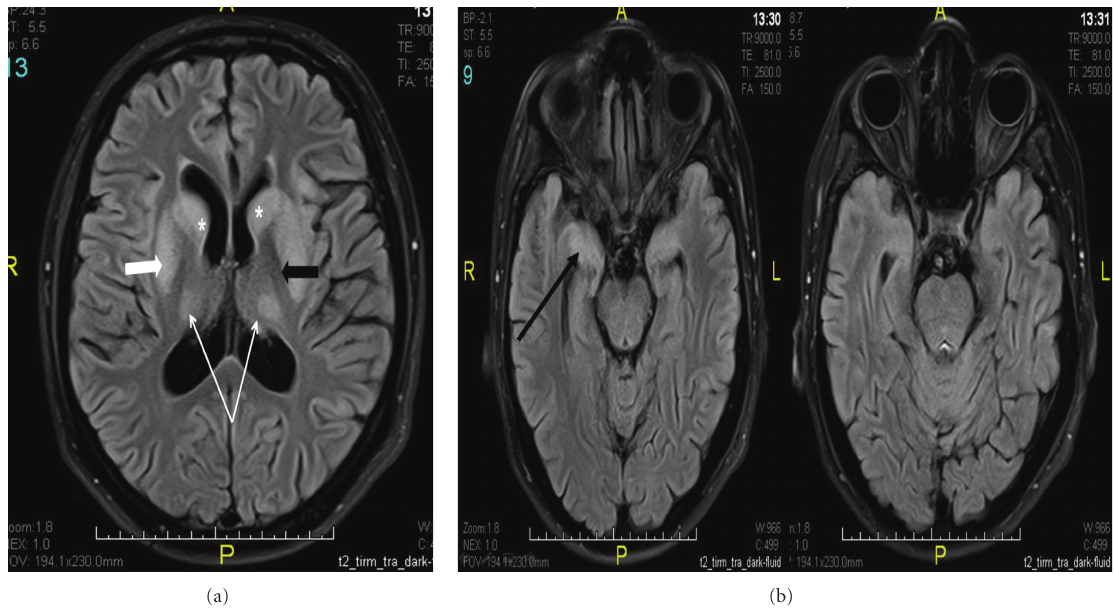
Figure 2: (a) MRI brain: axial FLAIR image showing hyperintense signal in the caudate nuclei bilaterally (asterisk marks), both putamina bilaterally (white thick arrow pointing to the right putamen), and both thalami (thin white arrows). Note the sparring of the globus pallidi (black thick arrow). (b) Axial FLAIR of the brain showing increased signal in the temporal lobes (namely, the anterior temporal lobes, particularly the hippocampi (black arrow)). The Pons show no sign of demyelination.